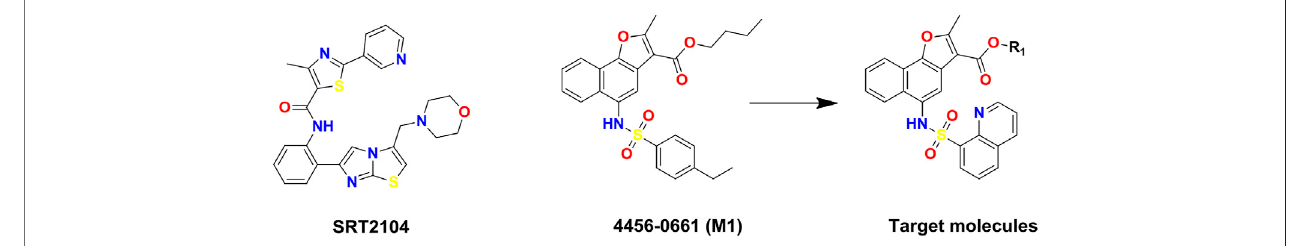
FIGURE 1 | Chemical structures of SIRT1 activators: SRT2104, lead compound 4,456 – 0661 (M1) and its naphthofuran derivatives.